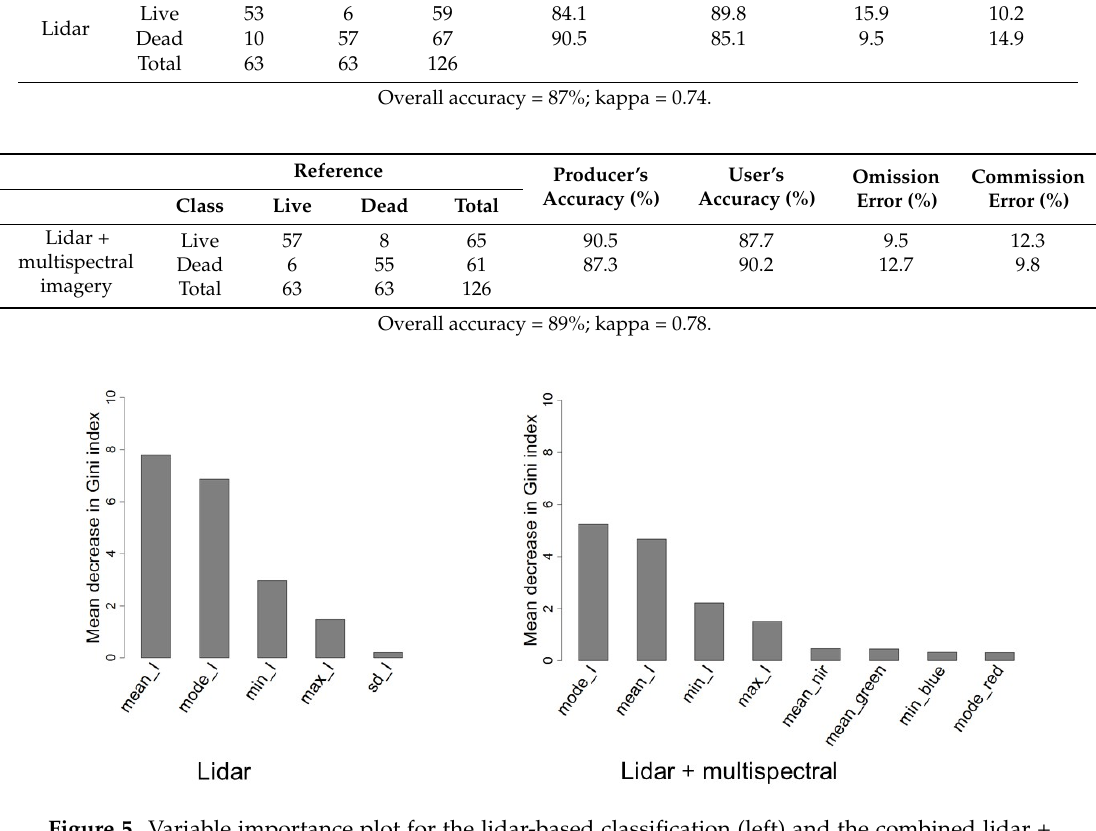
Figure 5. Variable importance plot for the lidar-based classification (left) and the combined lidar + multispectral imagery-based classification of live and dead tree crowns.